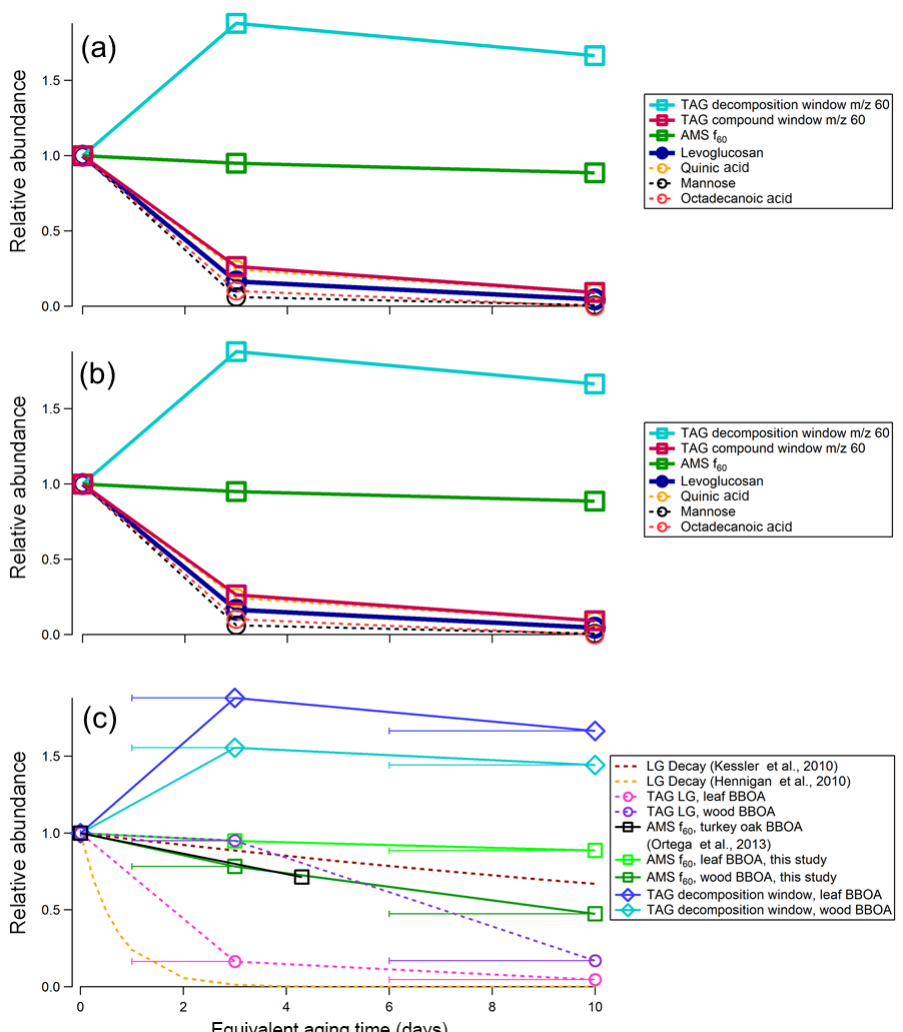
Figure 12. Relative changes in abundance for different m/z 60 fragmenting species in (a) leaf and (b) heartwood BBOA; (c) TAG and AMS m/z 60 species as a function of OH exp . Levoglucosan (LG) decay rates were calculated using two different literature k LG values (Hennigan et al., 2010; Kessler et al., 2010) with an assumed typical outdoor OH concentration of 1.5 × 10 − 6 moleccm − 3 (Mao et al., 2009). Additionally, normalized AMS f 60 values for turkey oak ( Quercus laevis ) BBOA obtained during the FLAME-3 campaign were adapted from Fig. 10b in Ortega et al. (2013) and are included for comparison. The x -axis error bars denote the equivalent aging time range and are applicable for all measurements obtained in this study, though they are only included in panel (c) to preserve figure readability.